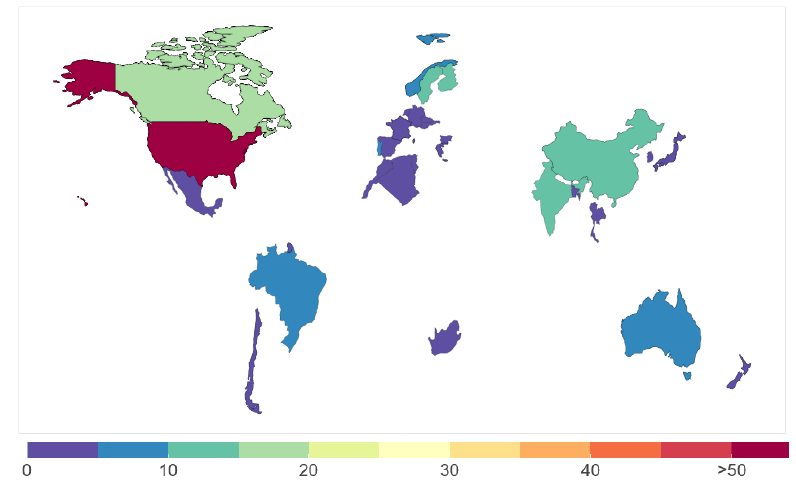
Figure 5. Number of publications per country.